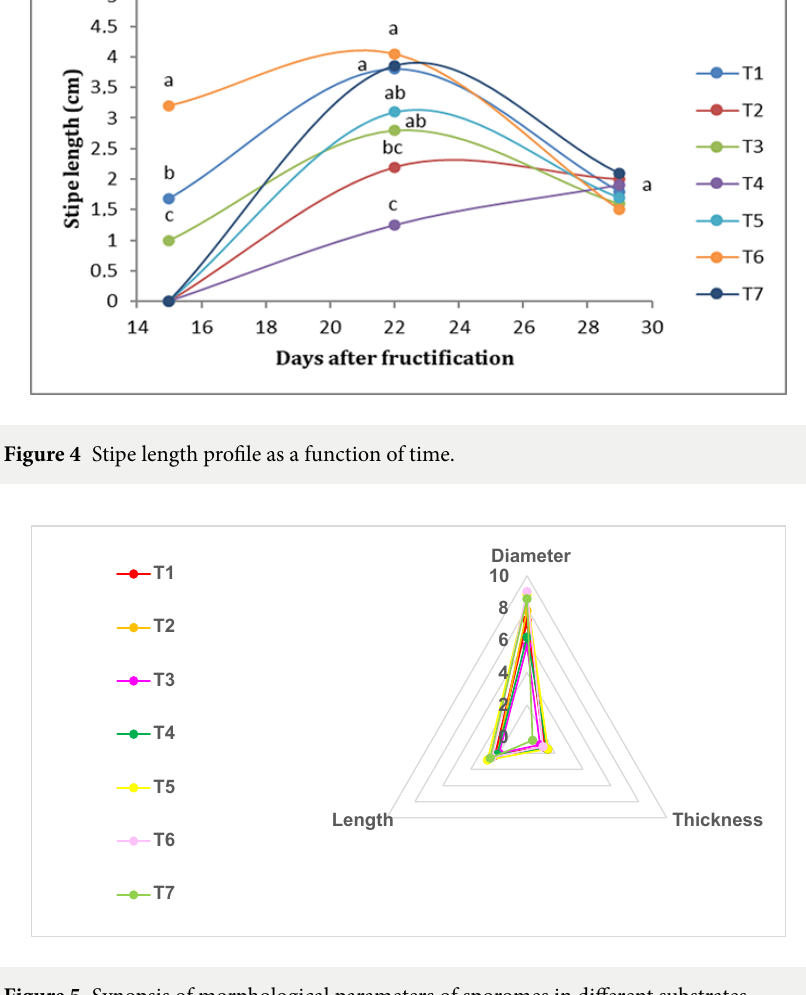
Figure 5 Synopsis of morphological parameters of sporomes in different